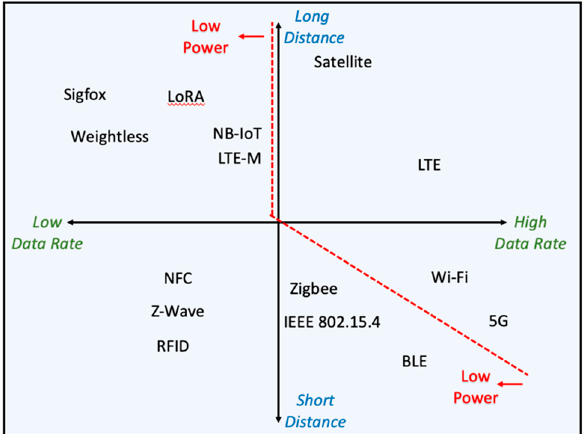
Figure 5. IoT communication architectures classified by distance and data rate in